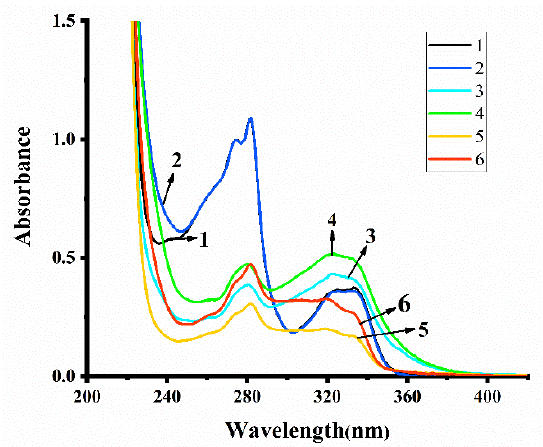
Figure 7. Absorption spectra of 20 μM of compounds 1 – 6 in Tris-HCl buffer.